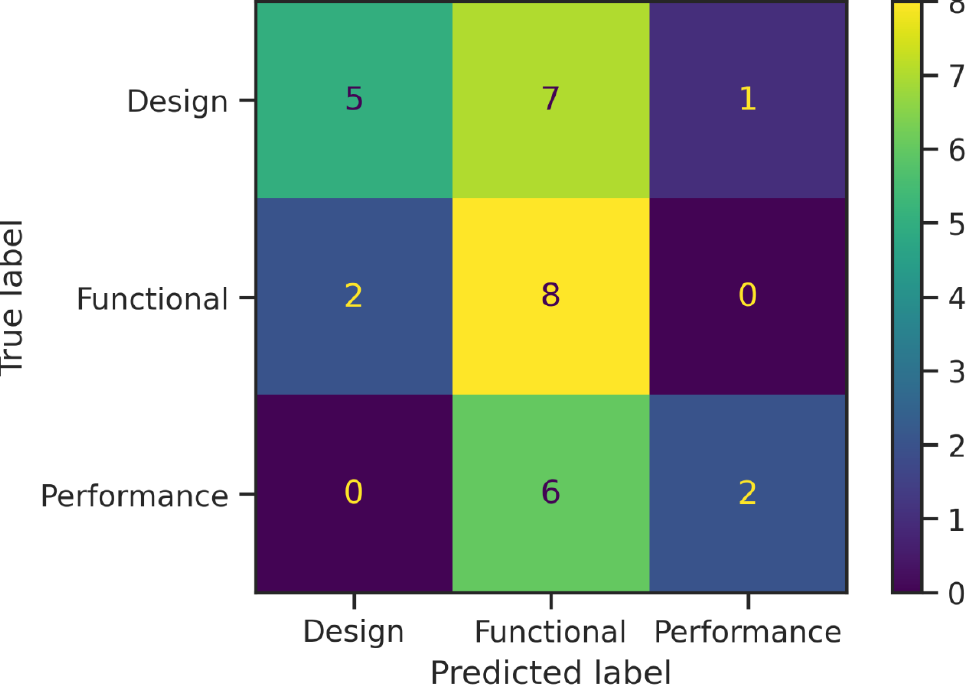
Figure 11. Confusion matrix showing the breakdown of the true and predicted labels by the bart- large-mnli model on the test